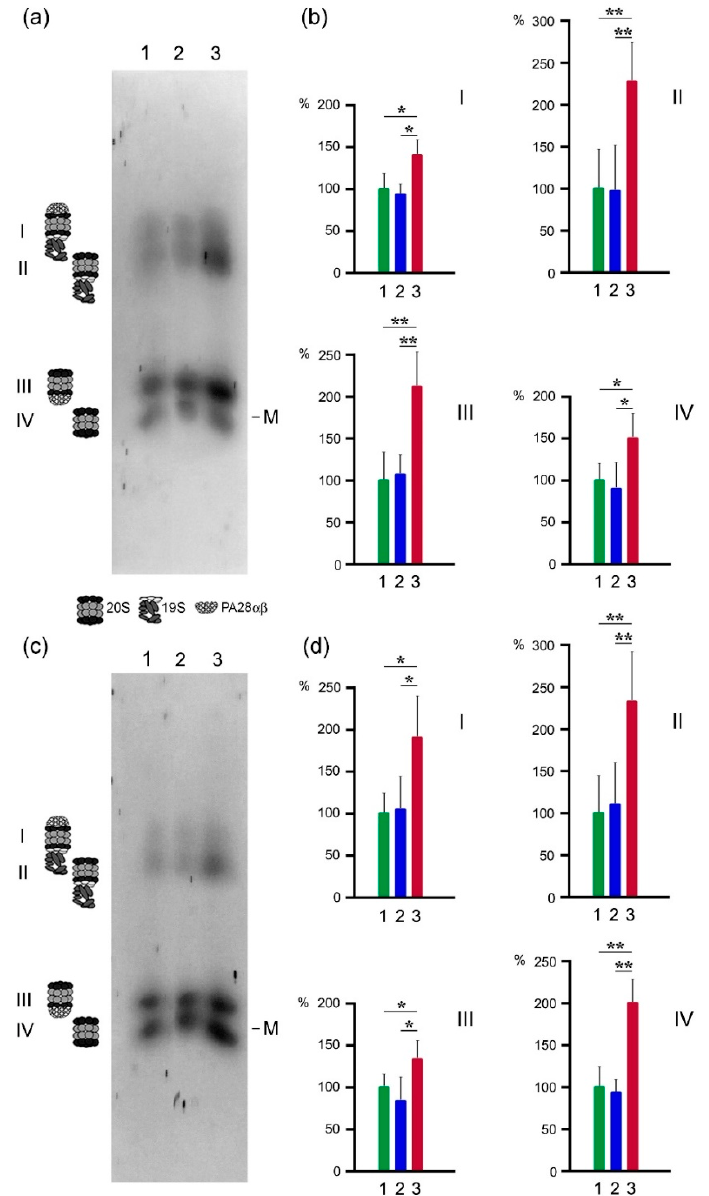
Figure 5. ChTL and LMP7 activities of proteasome subtypes in rectal adenocarcinoma and different intestine parts of patients. ( a ) ChTL activity in native PAG. ( b ) Relative ChTL activity for every gel zone. ( c ) LMP7 activity in native PAG. ( d ) Relative LMP7 activity for every gel zone. Thyroglobulin (670 kDa), labeled by dye Cy-3.5, was used as a marker (M) of molecular mass. Proteasome activity in intestine distal side in 2 cm from the tumor (taken as 100%) (1) and proximal side in 15 cm from the tumor (2) and tumor (3). Standard deviation is shown, p < 0.05 (*), p < 0.005 (**).